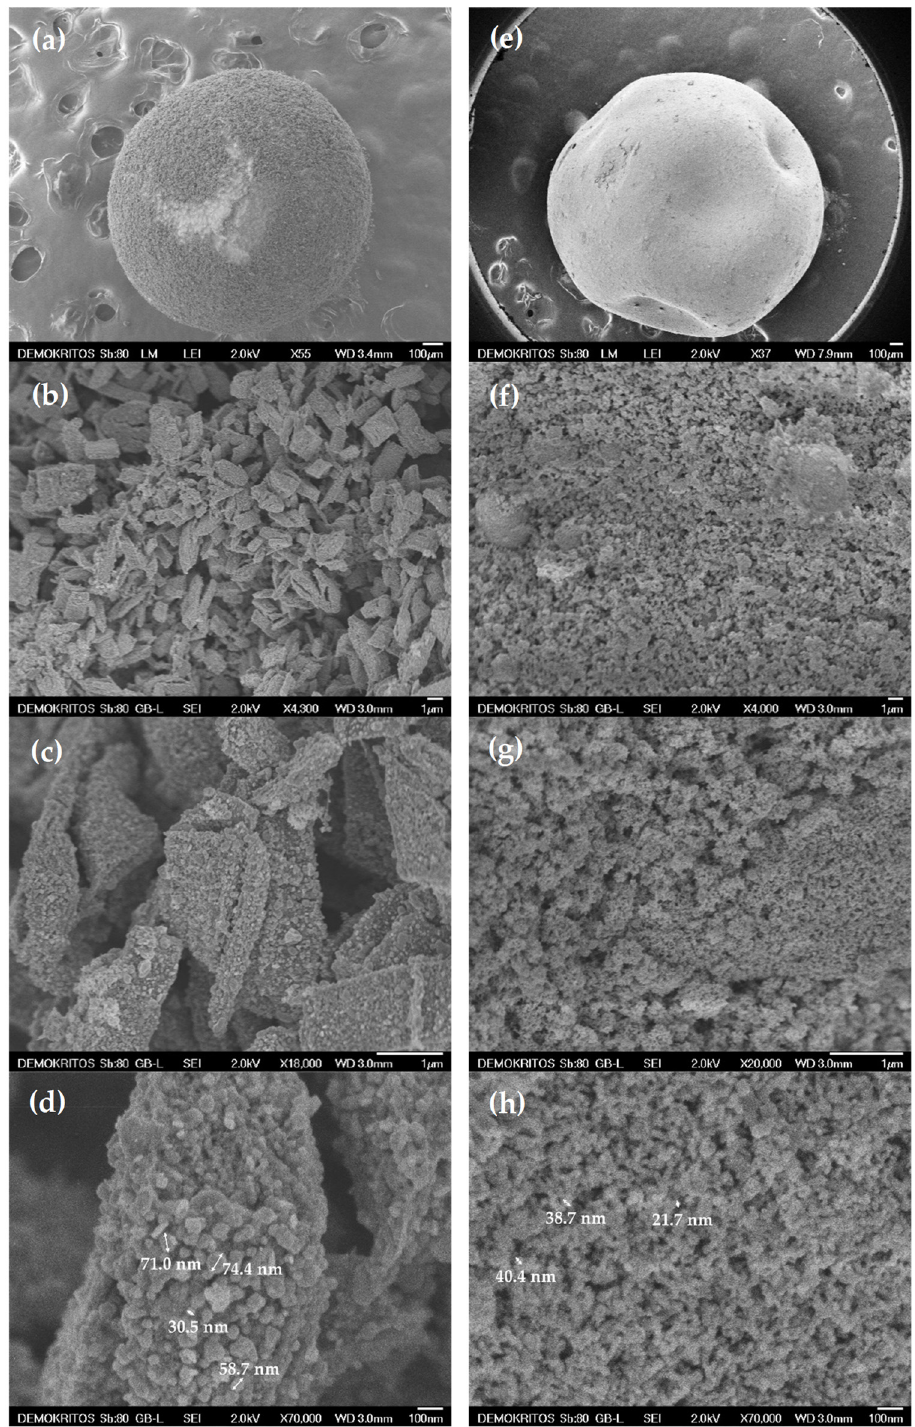
Figure 2. SEM images of the external surface of ( a – d ) B1_600 and ( e – h ) B2_600